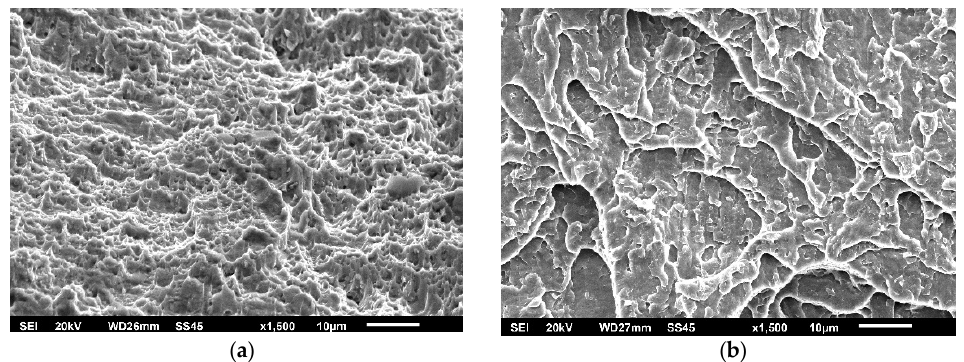
Figure 16. SA-387 Gr. 91 HAZ fractography. ( a ) SENB specimen 20 ◦ C, ( b ) CT specimen 575 ◦ C, 1500 × .